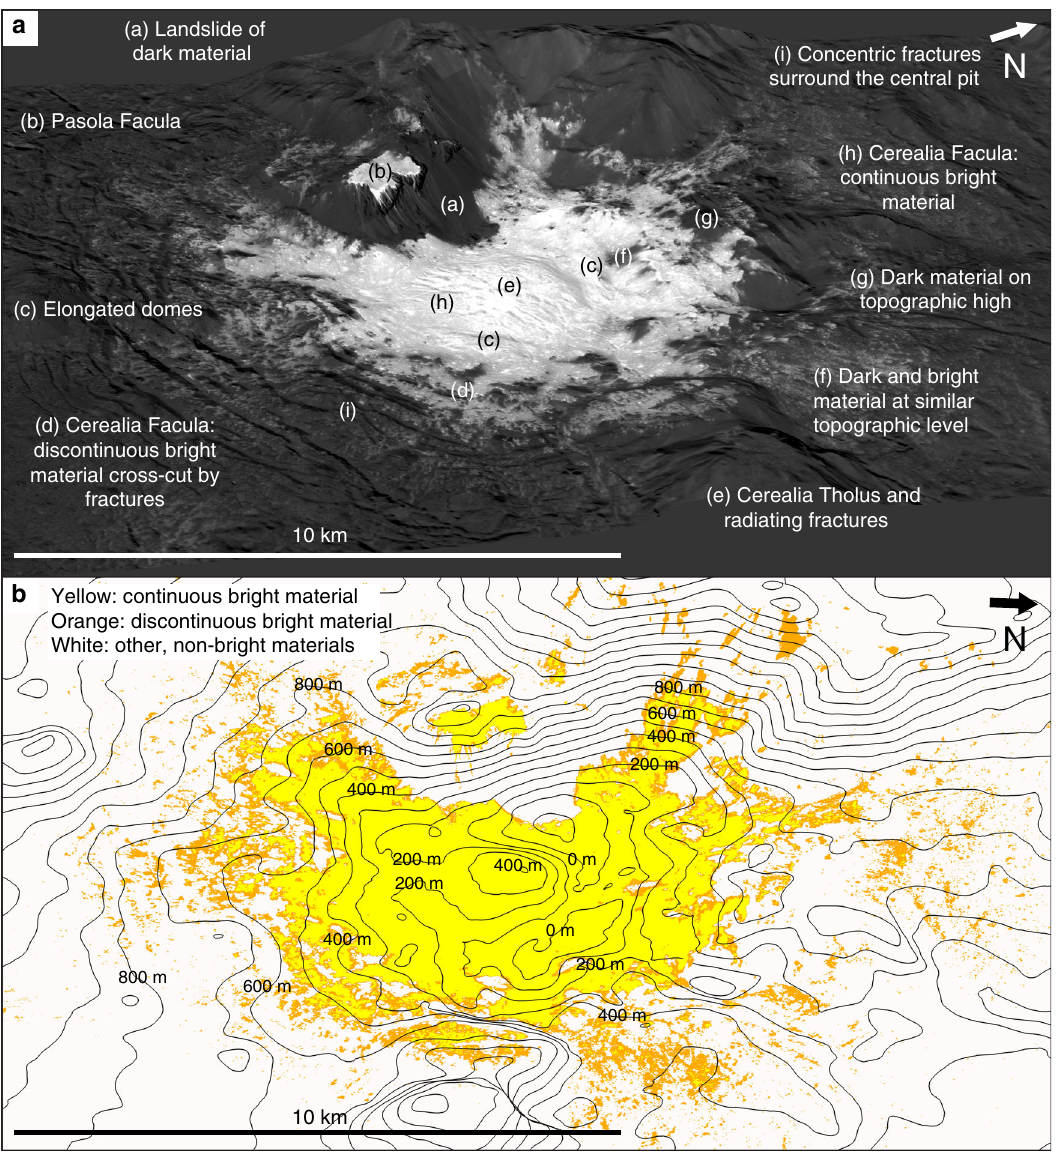
Fig. 2 Perspective views of the central region of Occator. a Perspective view with labels indicating key features discussed in the text, including Cerealia Facula, the central pit, Cerealia Tholus and Pasola Facula. The base mosaic is the ~10 m/pixel XM2 clear fi lter mosaic and is referenced to the LAMO DTM 59 . There is no vertical exaggeration. b Relationship between bright material and topographic lows, made using our classi fi ed version of the ~10 m/ pixel XM2 clear fi lter mosaic. The yellow classi fi ed material approximately corresponds to the continuous bright material, the orange to the discontinuous bright material and the white to other, non-bright materials. The contours (black lines) are spaced at 100 m, and are based on the LAMO DTM. The center coordinates of both views are 19° 37 ′ N and 120° 24 ′